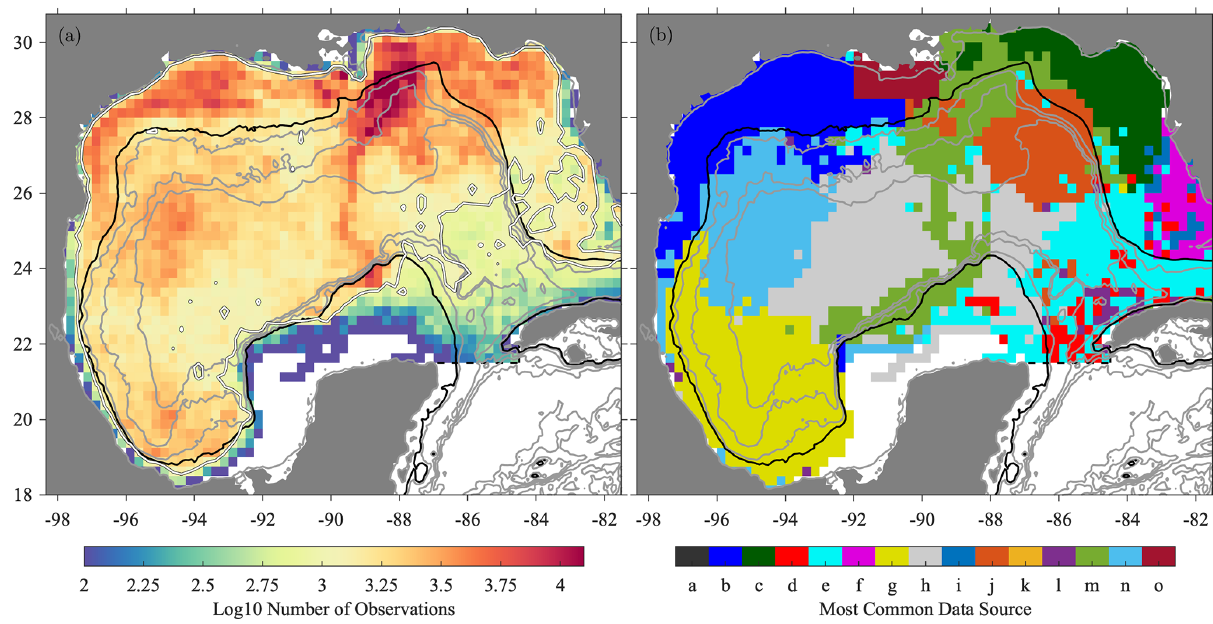
Figure 6. The spatial distribution of temporal sampling characteristics: (a) the number of hourly observations in 1 / 4 ◦ bins presented on a logarithmic scale, together with (b) the most common data source within each bin. The heavy white contour in (a) is 10 3 observations. The key to the letter codes in (b) is given in Fig.